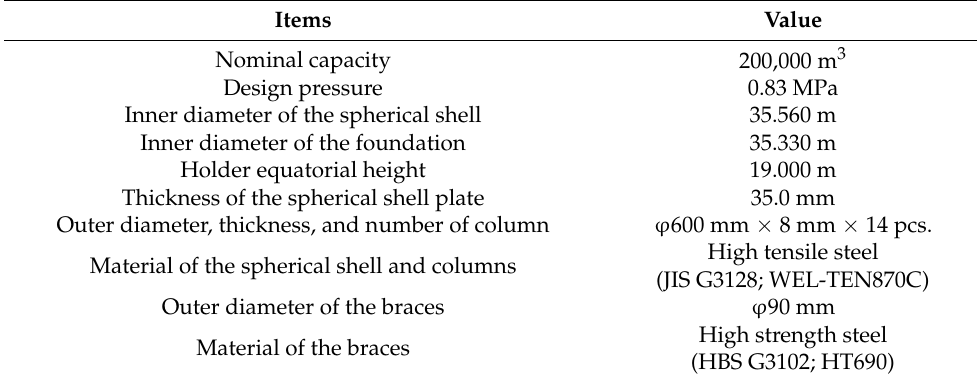
Table 3. Holder foundation/body material